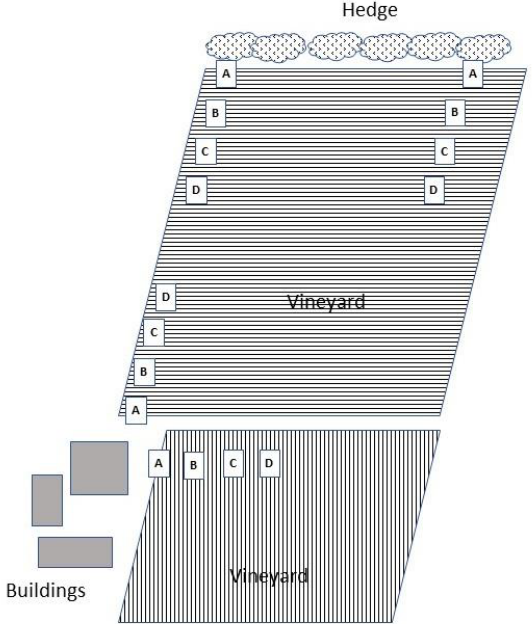
Figure 1. Example of trap position in the study on the effects of distance from vineyard margins on E. vulnerata colonization patterns (AC vineyard in 2017).